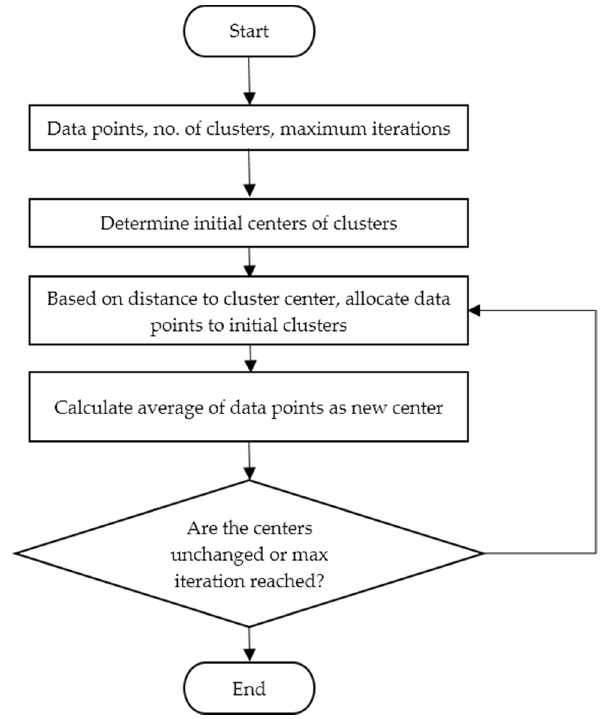
Figure 1. Flowchart of the k-means clustering algorithm.